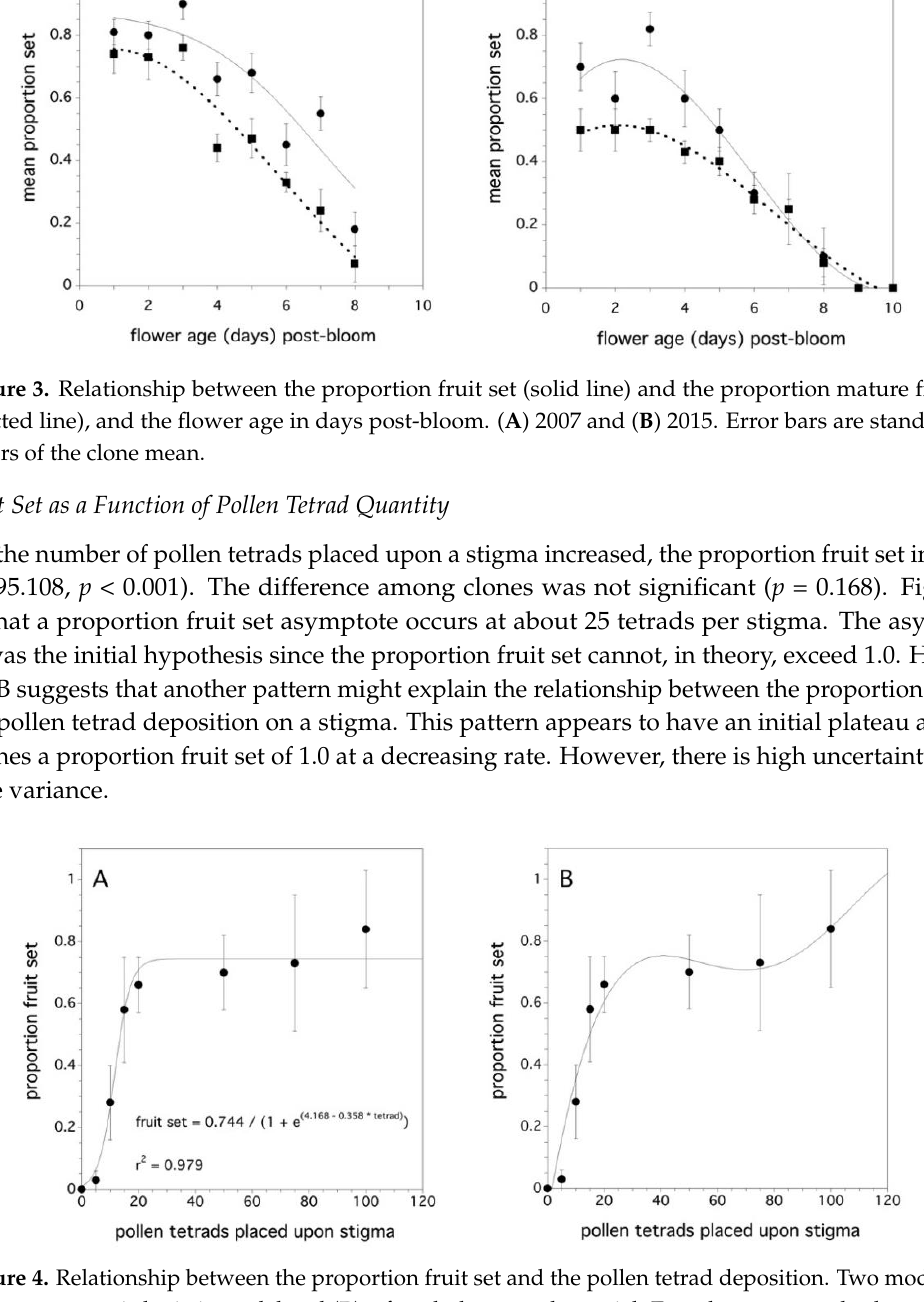
Figure 4. Relationship between the proportion fruit set and the pollen tetrad deposition. Two models: ( A ) an asymptotic logistic model and ( B ) a fourth degree polynomial. Error bars are standard errors.